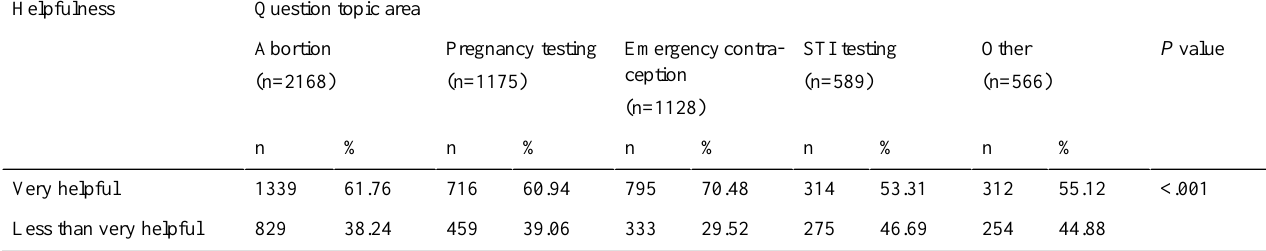
Table 3. Differences in user-reported program helpfulness postchat by question topic (n=5626). Question topic